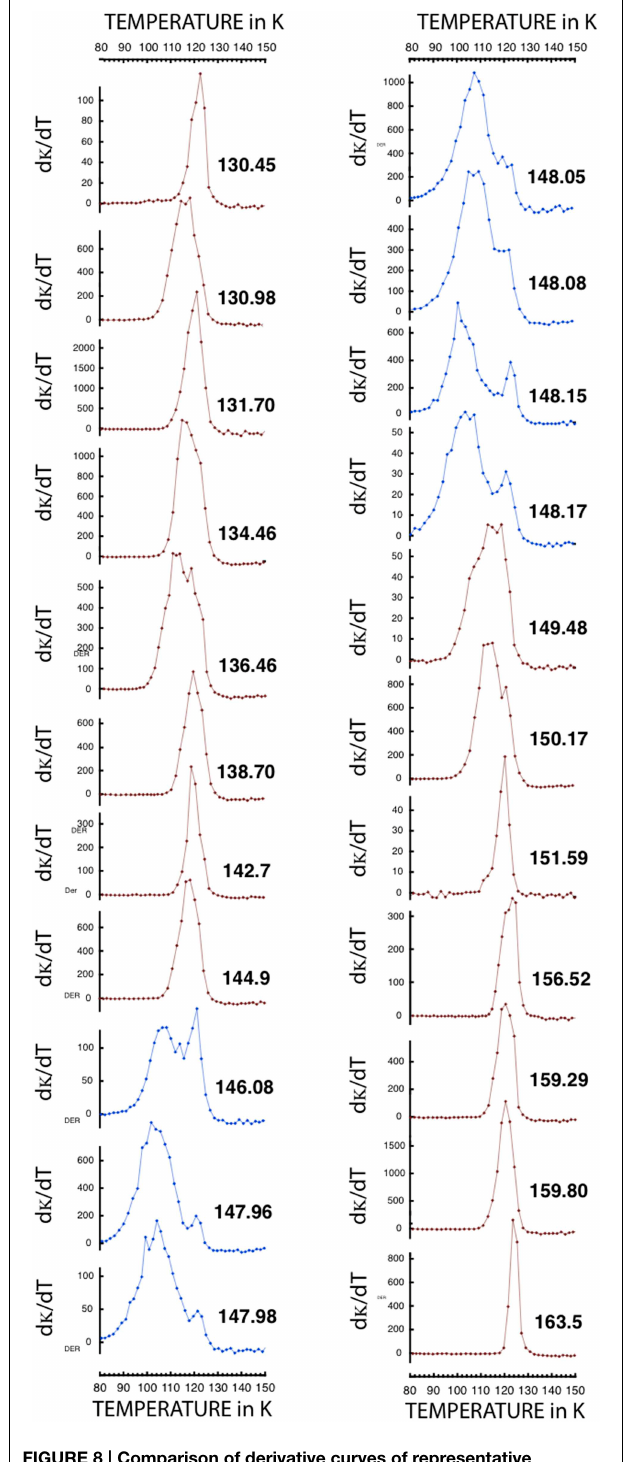
FIGURE 8 | Comparison of derivative curves of representative low-temperature susceptibility curves between 130.45 and 163.5m depth. Red curves: 1 T v , blue curves: ‘2 T v interval’ between 146.08 and 148.17 where 2 peaks are clearly